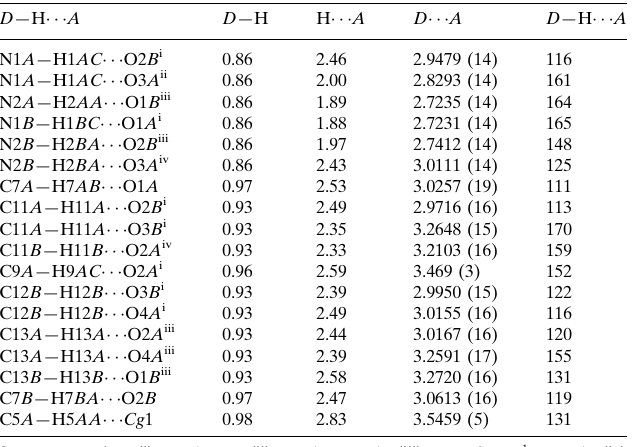
Hydrogen-bond geometry (A˚ , (cid:3)